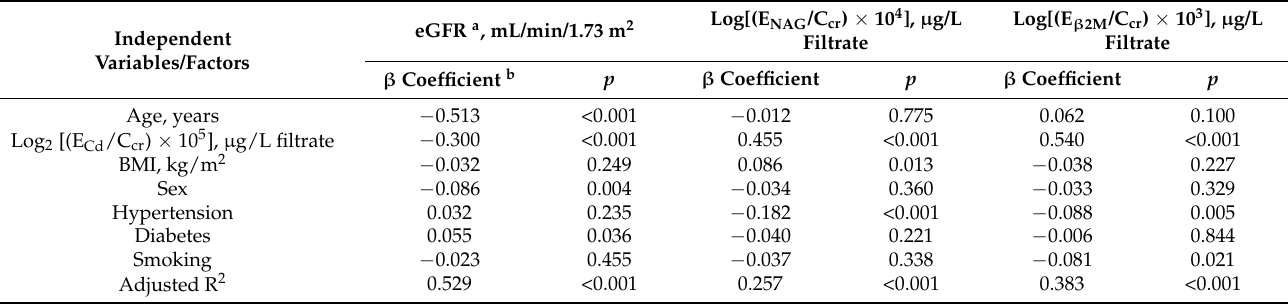
Table 4. Associations of the markers of kidney effects with E Cd /C cr